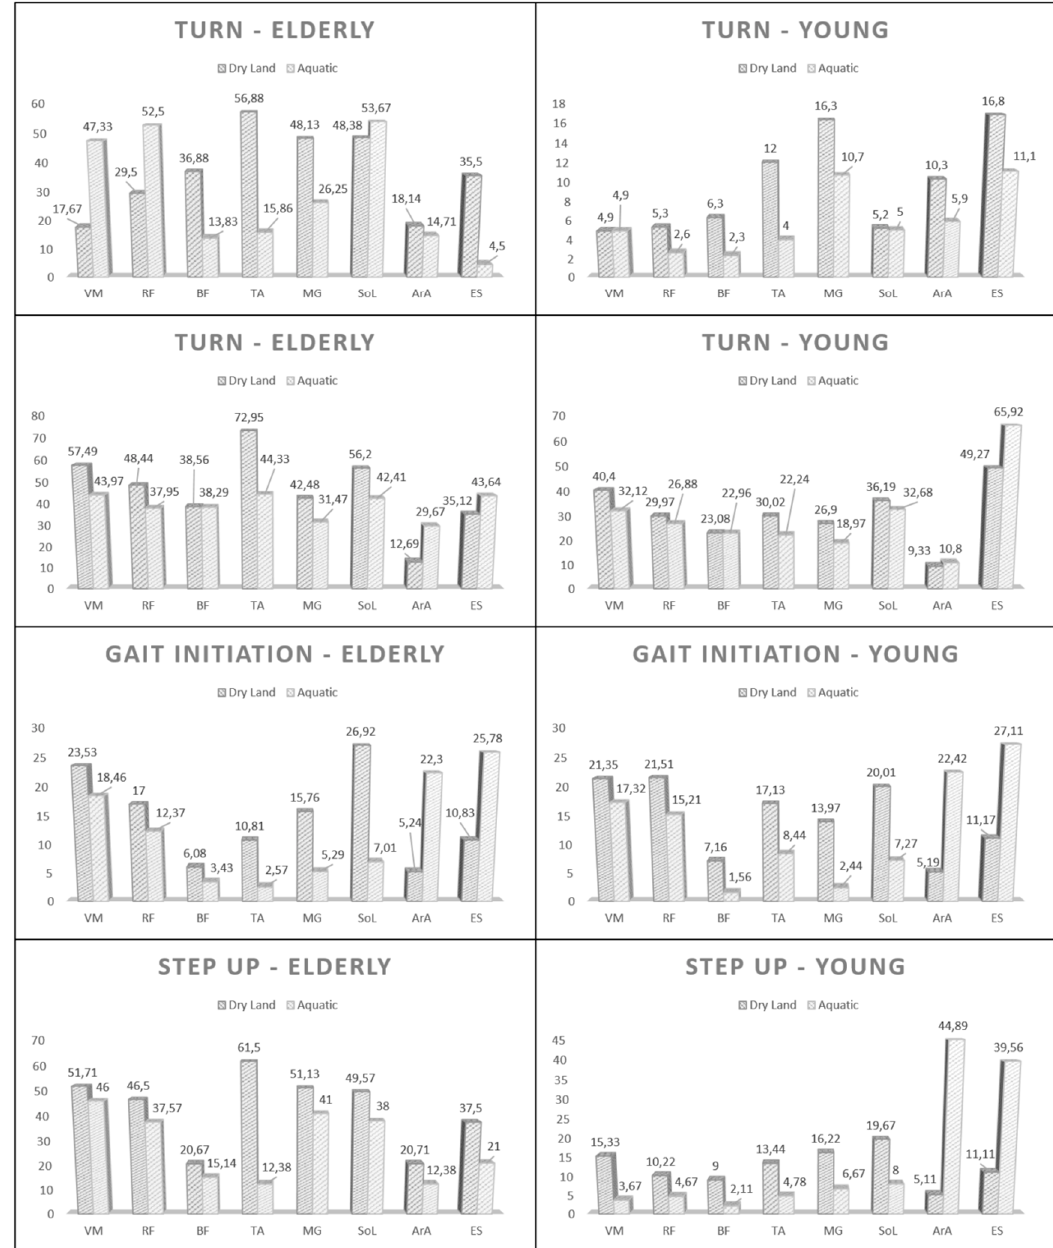
Figure 4. Comparison, within the same group (elderly or young), of normalized muscle activation, in both settings (dry land or aquatic environment).